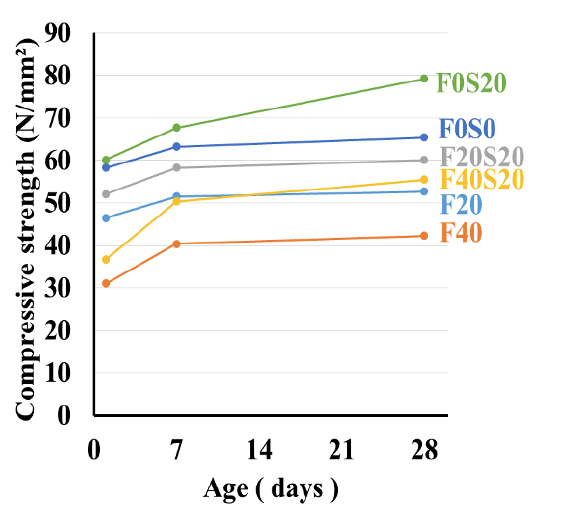
Figure 1. Compressive strength of mortar under steam curing.